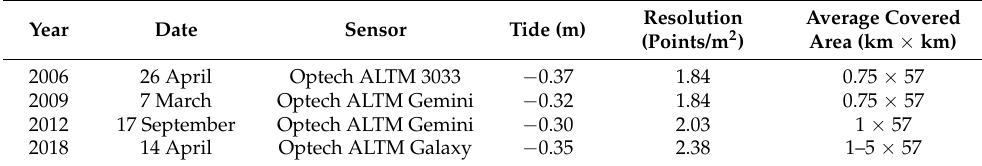
Table 2. Main characteristics of the LiDAR surveys analyzed in this study (ALTM: Airborne Laser Terrain